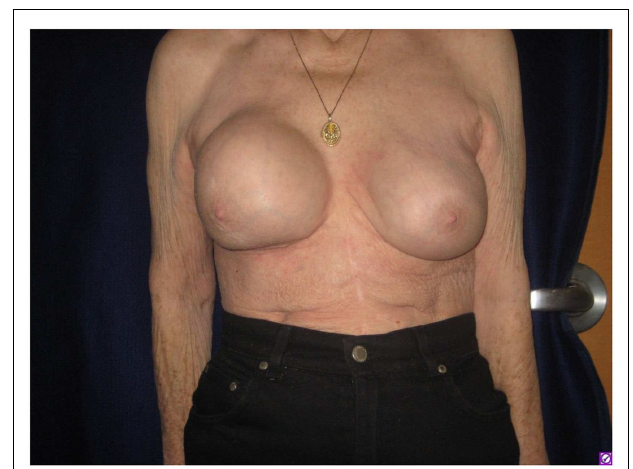
FIGURE 1 | Firmness and marked increase in size of the right breast as seen on presenting physical examination .